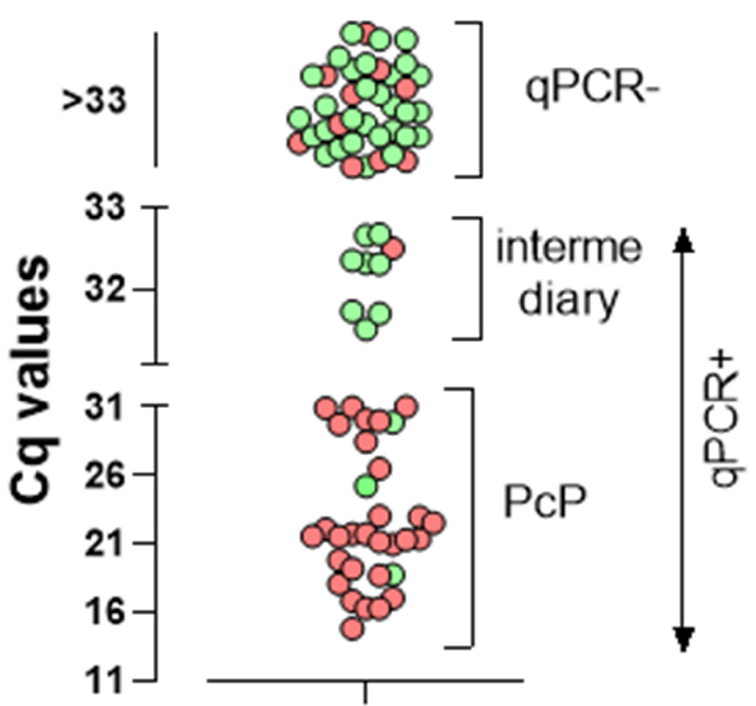
Figure 1. Distribution of the Cq results of the qPCR performed with IS of patients with AIDS and suspected Pneumocystis pneumonia (PcP) according to the low (green) or high (red) clinical index for PcP. Each symbol represents one patient. PcP (n = 32): positive qPCR with low Cq values indicating high fungal load. Intermediary group (n = 9): positive qPCR with high Cq values indicating low fungal load. qPCR-: n = 45.